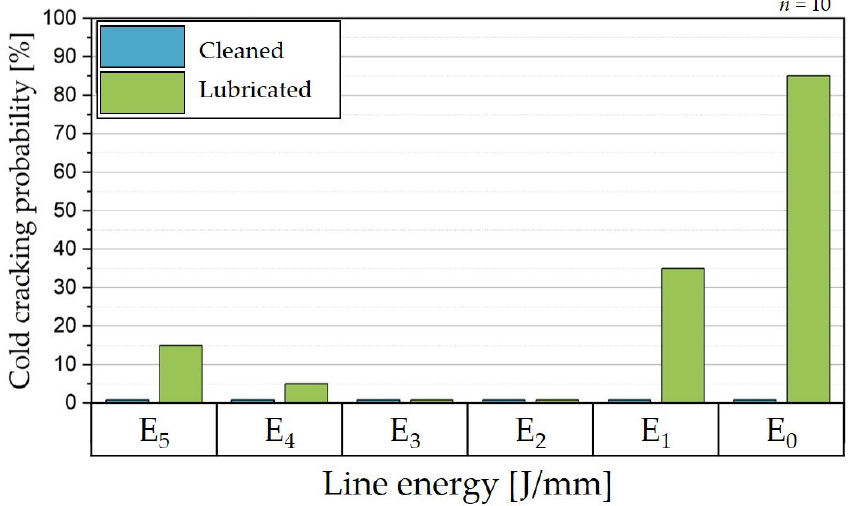
Figure 10. Difference in cold cracking probability of steel A depending on line energy and surface condition.